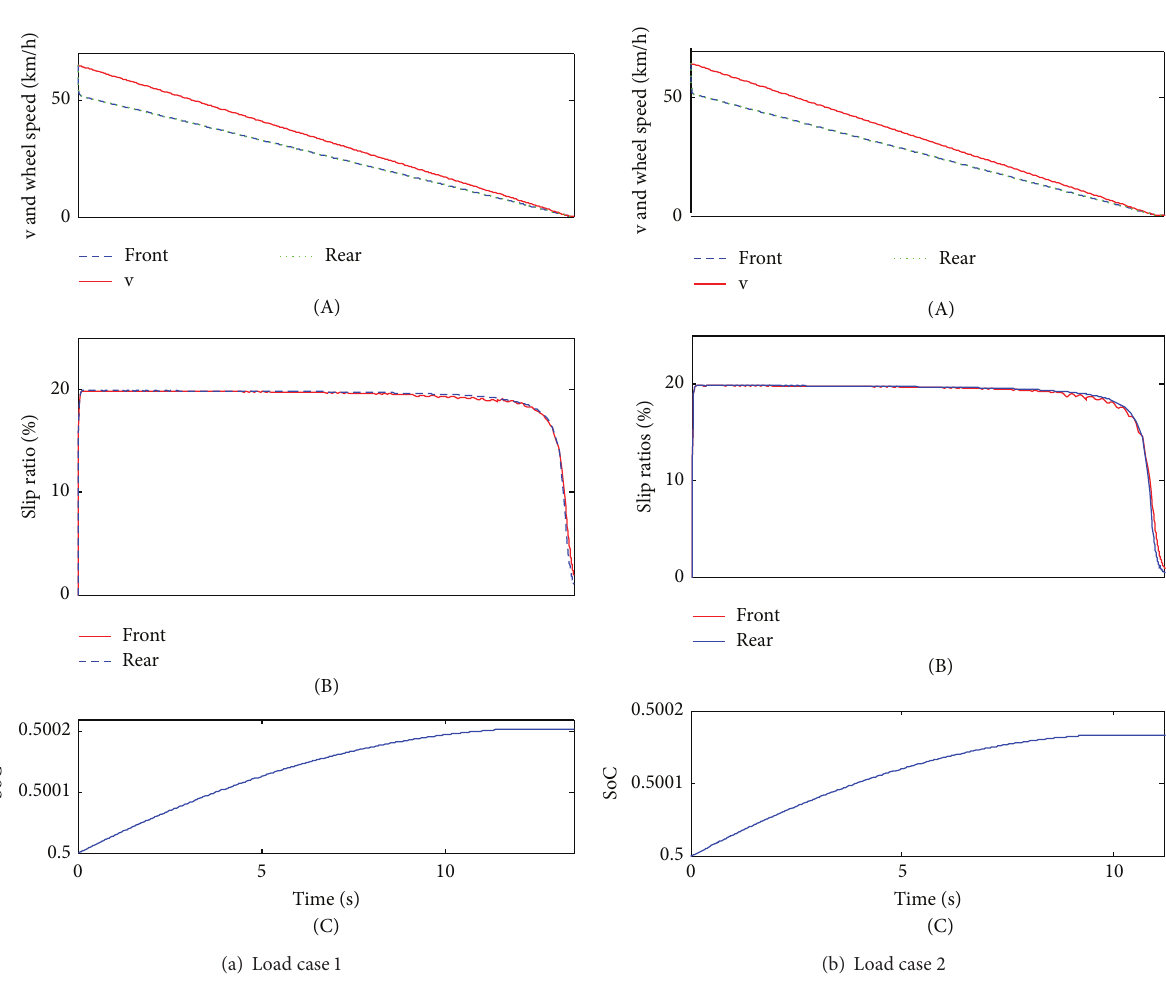
Figure 8: The simulation results of low and uniform load